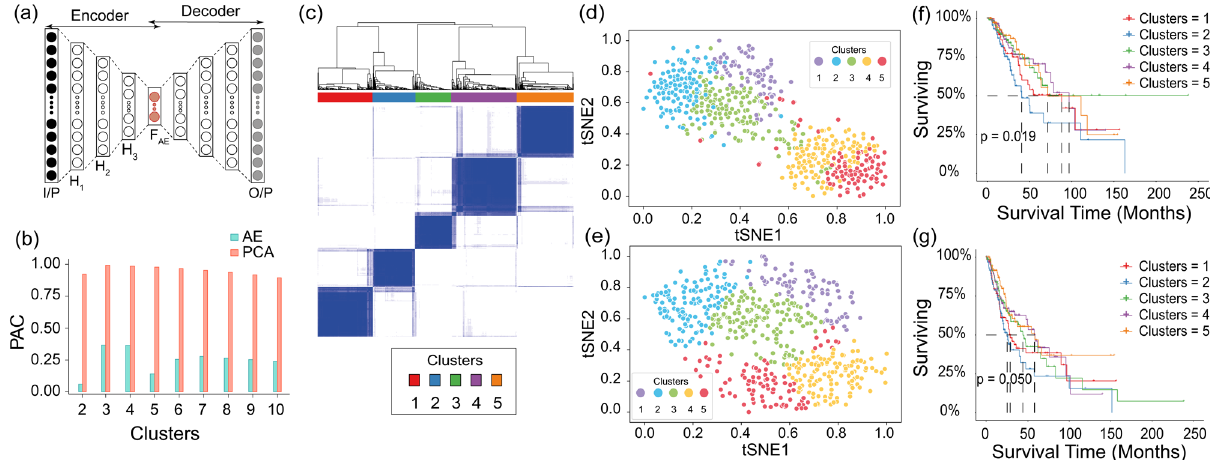
Figure 2. ( a ) Architecture of the autoencoder (AE) used in this study. Here, H 1 , H 2 , and H 3 are the first, second, and third hidden layers with 2000, 1000, and 500 nodes, respectively. F AE is the encoded representation from the bottleneck layer with 100 nodes. ( b ) Proportion of ambiguously clustered pairs (PAC) values obtained from the CDF curve for consensus clustering of reduced dimension data obtained from AE and PCA. ( c ) Consensus clustering heatmap for K = 5. ( d ) and ( e ) t-SNE plots for samples in original dimension, and reduced dimension obtained using AE. Samples are colored based on the labels obtained by consensus K -means clustering. ( f ) and ( g ) Kaplan-Meier plots for overall (OS) and disease-free survival (DFS) in the clusters obtained by consensus K -means